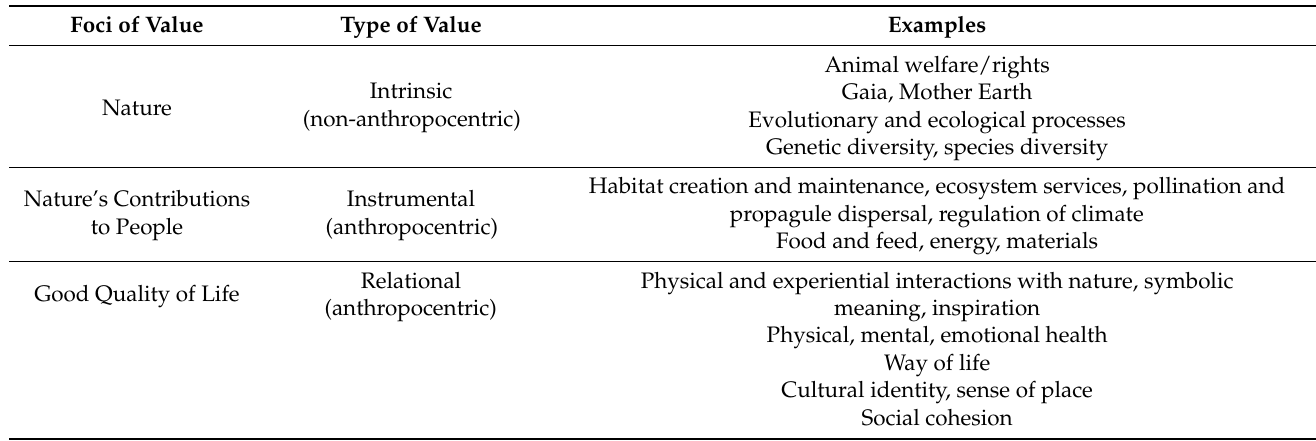
Table 1. Diverse values related to nature, nature’s contributions to people, and good quality of life. Foci of